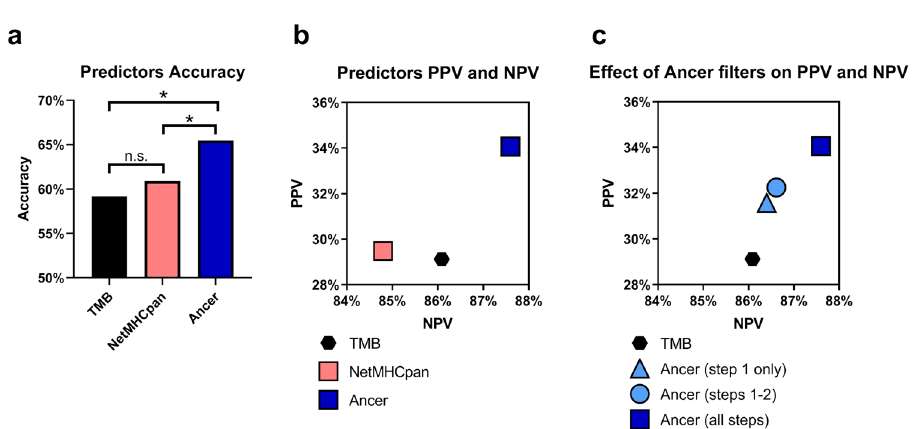
Figure 6. Prediction of bladder cancer patient five-year survival rate. Ancer pipeline analysis improves prediction of five-year survival compared to TMB- or NetMHCpan-based predictors. BLCA patients were predicted to survive more or less than five years based on their mutational or neoepitope burdens. Predicted survival status was compared to observed overall survival. ( a ) Accuracy of the five-year survival predictions. * p -value < 0.05, McNemar’s test. ( b ) Positive (PPV) and negative predictive values (NPV) obtained for the TMB, NetMHCpan, and Ancer predictors. ( c ) PPVs and NPVs obtained using truncated and full versions of the Ancer pipeline. The increased NPV as compared to NetMHCpan and TMB suggests that an analysis that identifies tolerated or tolerogenic epitopes (Ancer) may be better suited to identify patients at a greater risk of earlier mortality (~ 9 out of 10 correct predictions) than the other types of